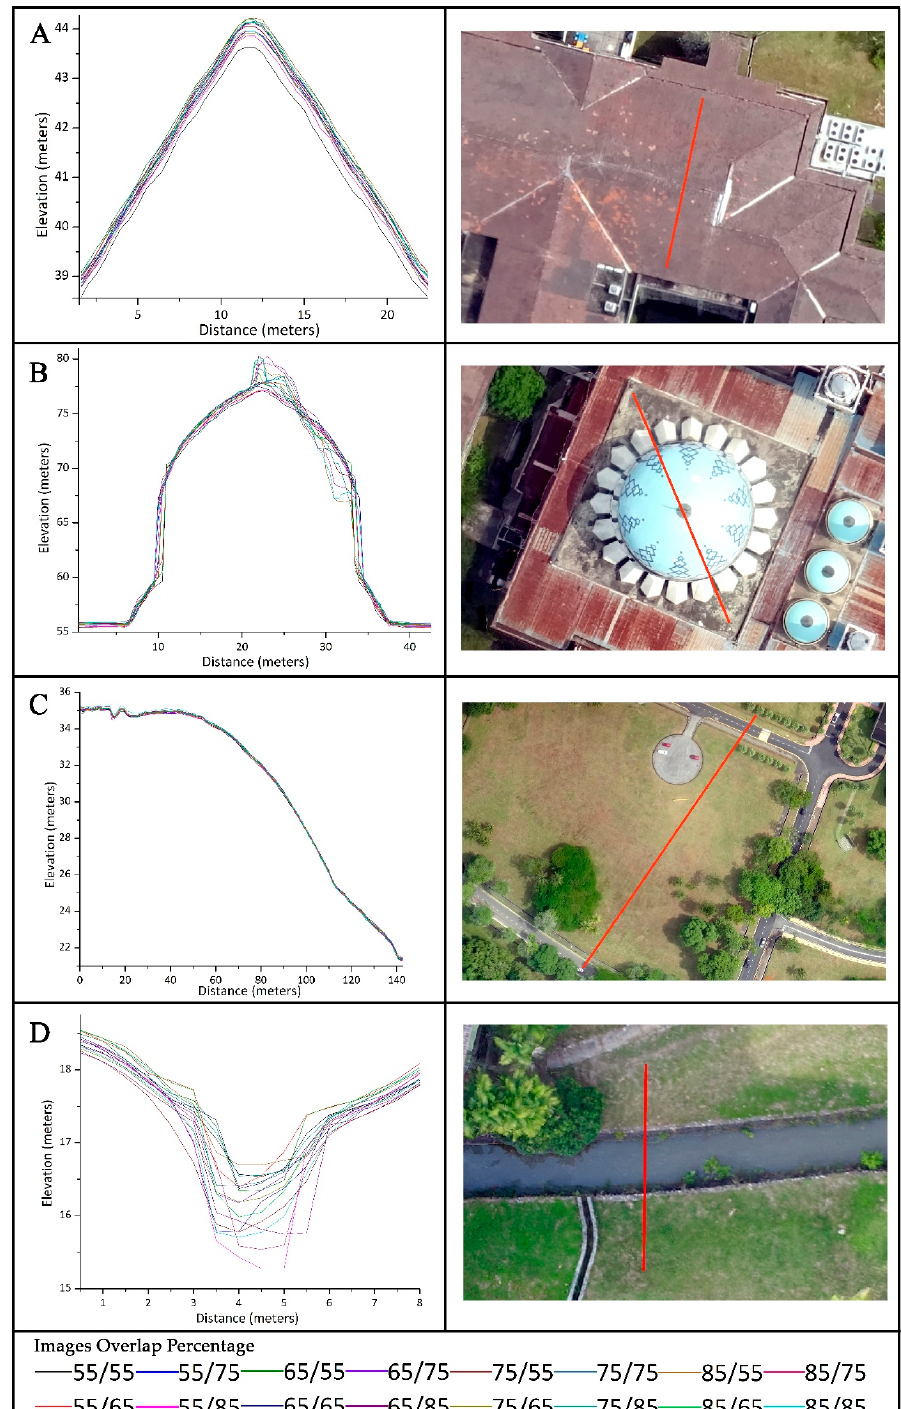
Figure 6. Profile graph for large scale topographic investigations, ( A ) Building roof top typical of the Tropical region, ( B ) Dome, ( C ) Slope, ( D ) Stream.